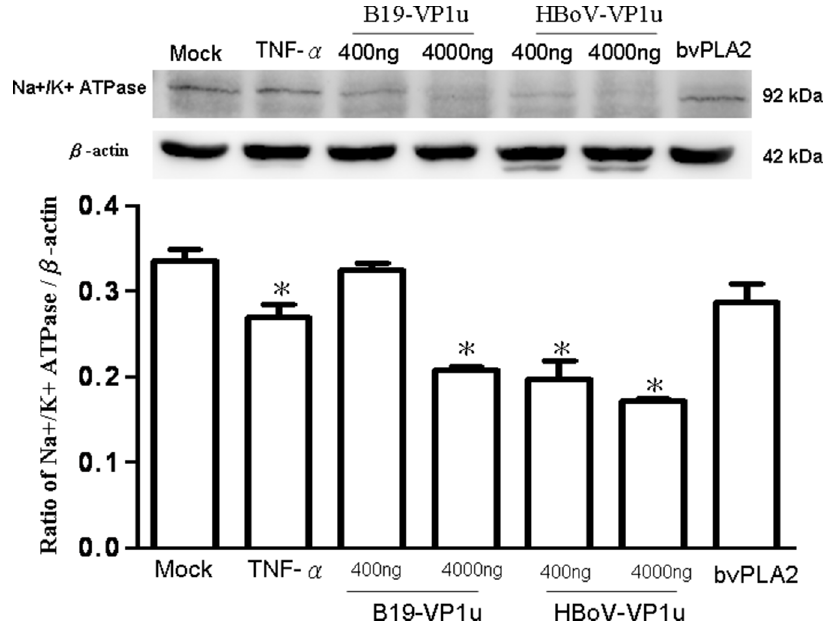
Figure 4. Expression of Na + /K + ATPase. Cell lysates obtained from A549 cells treated with PBS (mock), TNF- a (10 ng/ml), two dosages of recombinant B19-VP1u and HBoV-VP1u (400 ng/ml and 4000 ng/ml) and bee venom PLA2 (10 ng/ml) were probed with antibodies against Na + /K + ATPase. Quantified result was shown in the lower panel. Similar results were observed in three independent experiments and * indicates the significant difference as compared to the mock, P , 0.05.